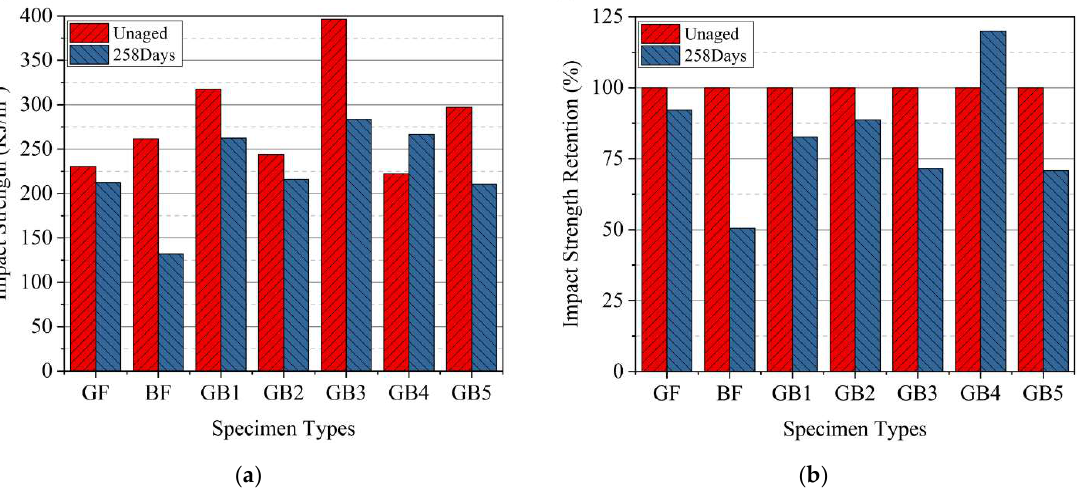
Figure 11. Impact ( a ) strength ( b ) strength retention of specimens in dry and seawater aged condition.